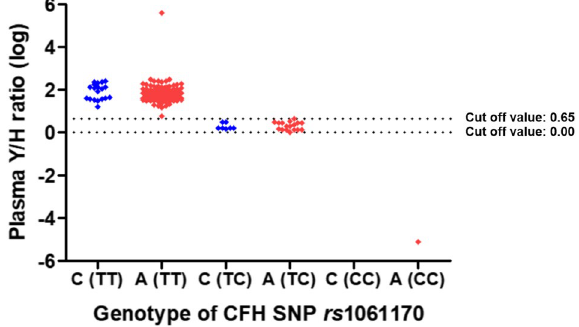
Figure 4. The distribution of logarithm plasma CFH tyrosine/histidine variant protein ratio according to the genotype of complement factor H single nucleotide polymorphism rs 1061170 and the presence of age-related macular degeneration. C, control; A, age-related macular degeneration; CFH, complement factor H; SNP, single nucleotide polymorphism; Y, tyrosine; H, histidine; log, logarithm.